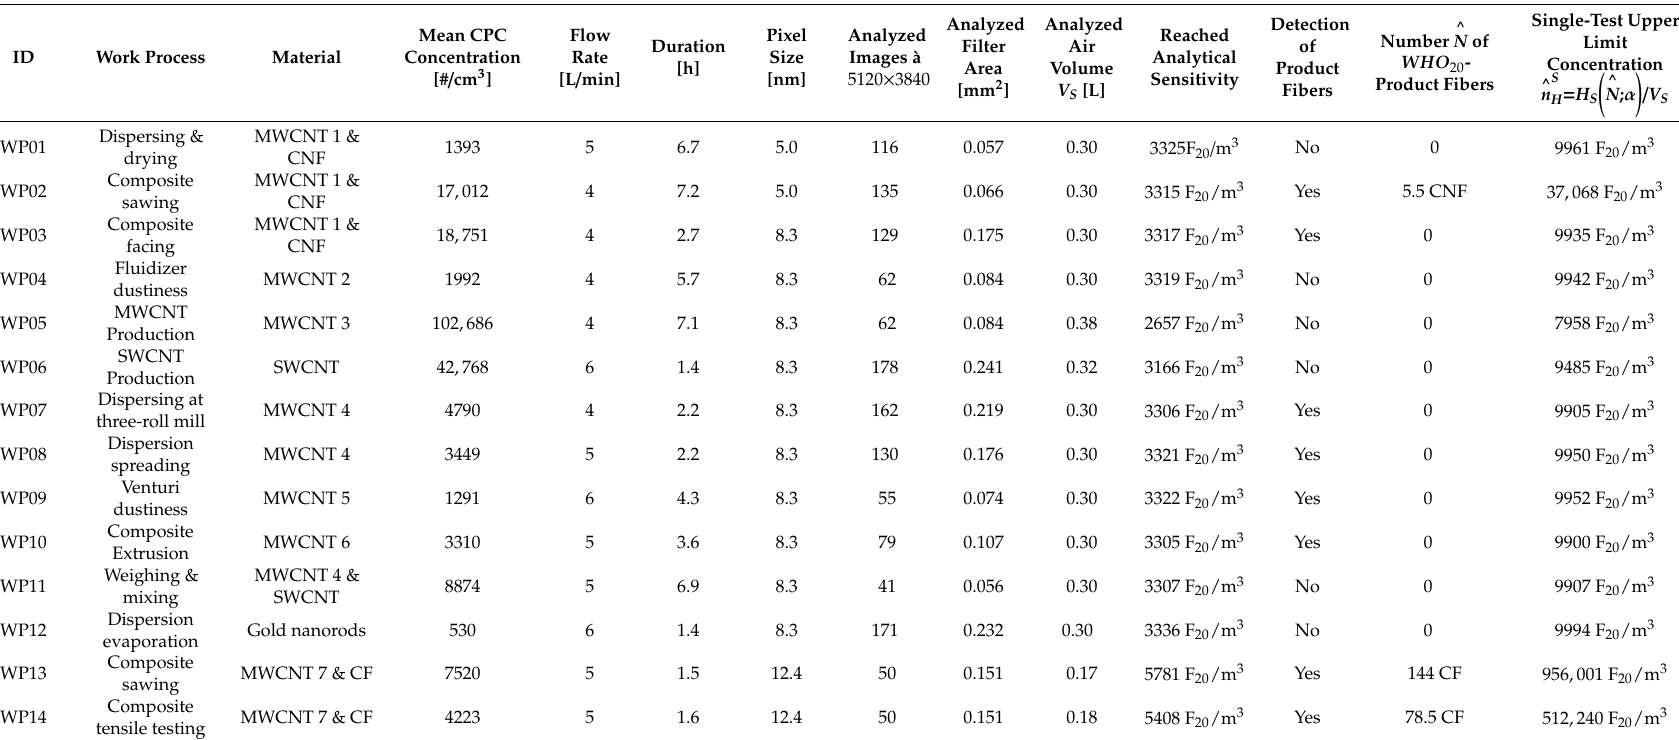
Table 14. Performed workplace exposure assessments with indication of the parameters used for sampling in the nearfield of the emission source (outside fume hoods or safety workbenches if used) and resulting data for the SEM analysis for a tested limit concentration of n EL = 10,000 WHO 20 /m 3 and a significance of α = 5 %. The e ff ective filter diameter of the used sampling heads was d o = 22